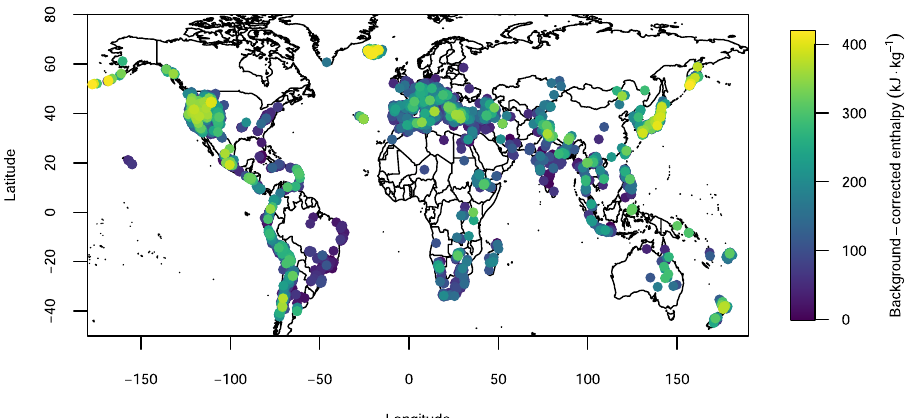
Fig.4|Thermalspringsbackground-correctedenthalpies. Mapshowingworlddistributionofcalculatedbackground-correctedsaturatedliquidenthalpy(inkJkg − 1 )for 3680 thermal spring areas (map created with maps 50 R package).